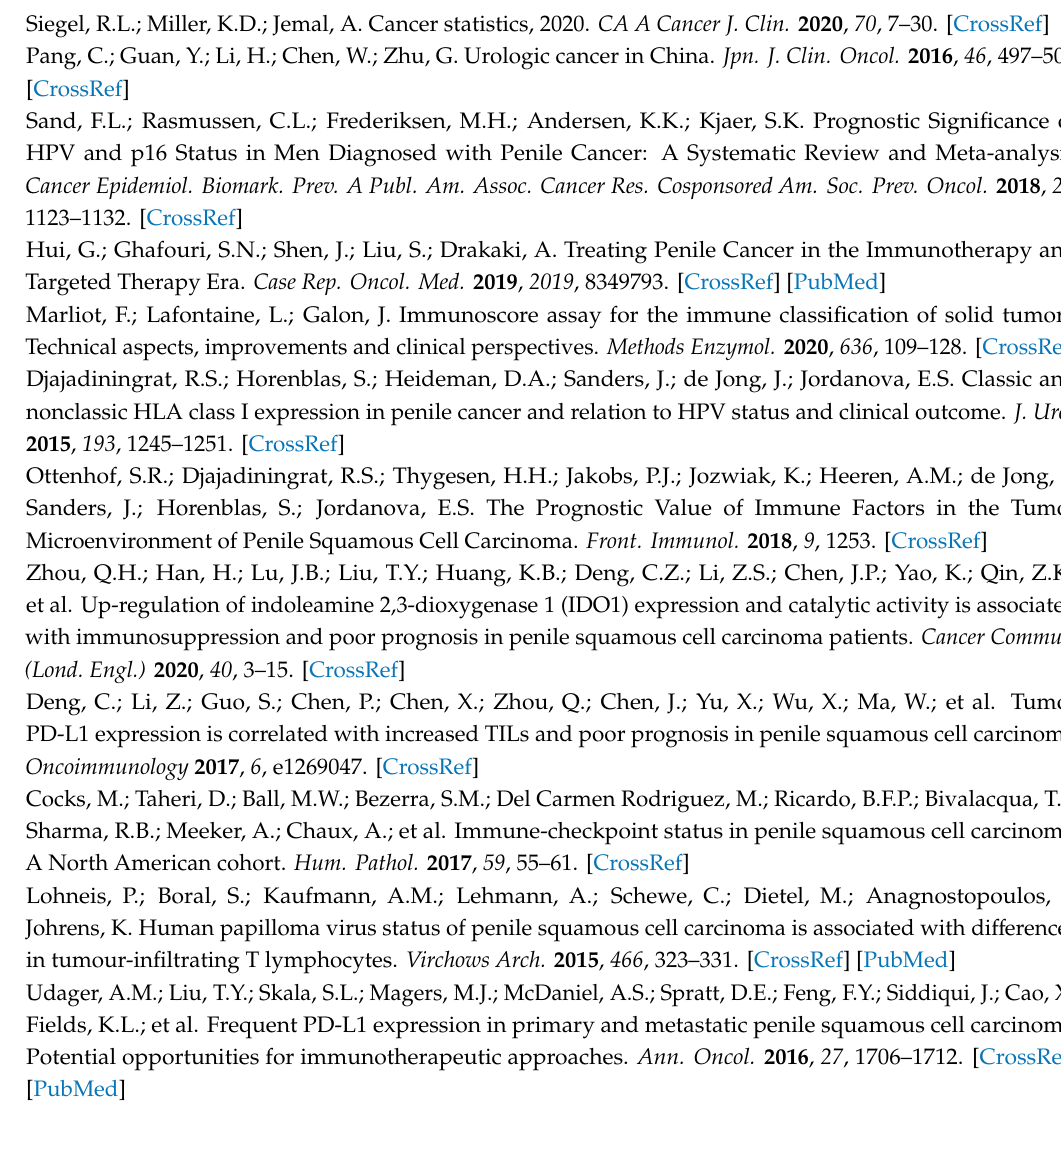
of immune markers, Table S3: Univariable and multivariate Cox regression analysis for disease-specific survival (DSS) based on the continuous variables of immune markers, Table S4: Univariable and multivariate logistic regression analysis of clinicopathological factors associated with lymph node metastasis (LNM), Table S5: PD-L1 and Siglec-15 associated with immune clusters, Table S6: Role of immune markers in tumor progression and the represented inflammatory cell types, Table S7: Levels of immune markers expressed in di ff erent clusters